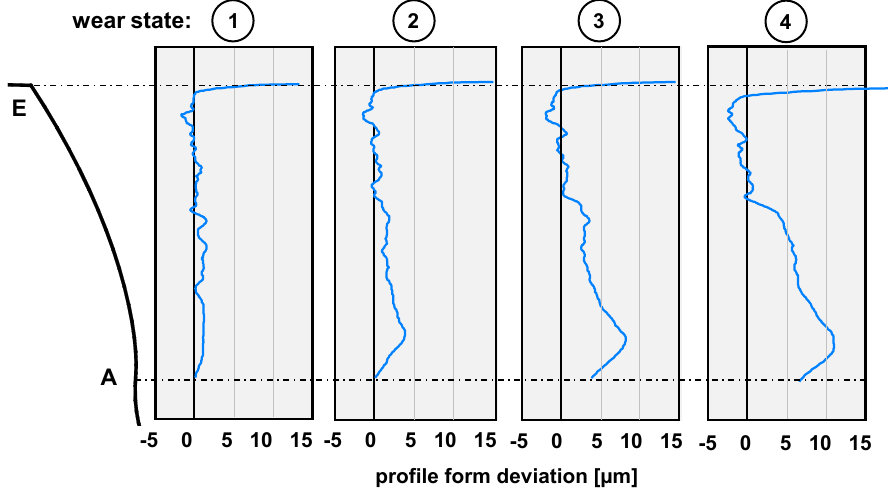
Figure 5. Profile form deviation of the gear teeth for the different wear conditions.